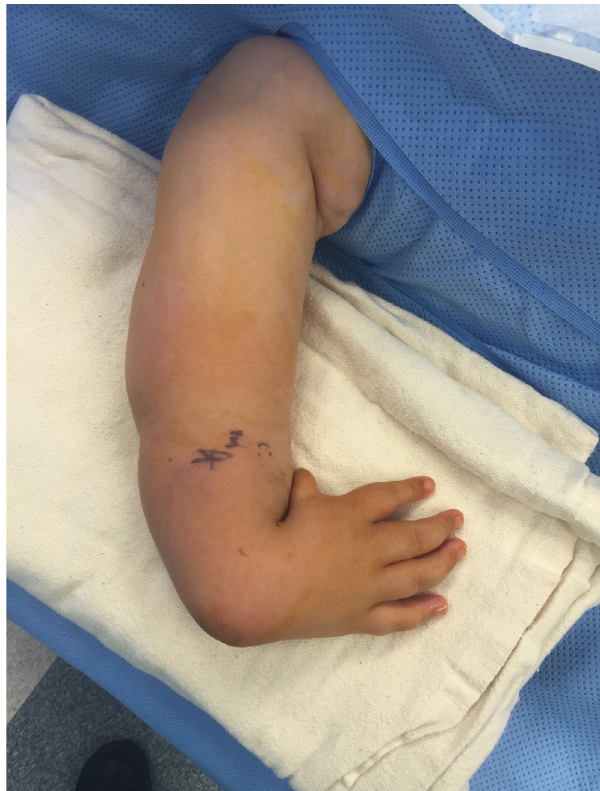
Figure 26. Photograph of the hand before